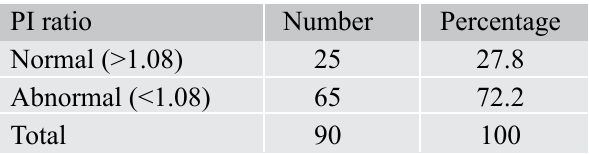
Table II: Distribution of normal and abnormal C/U